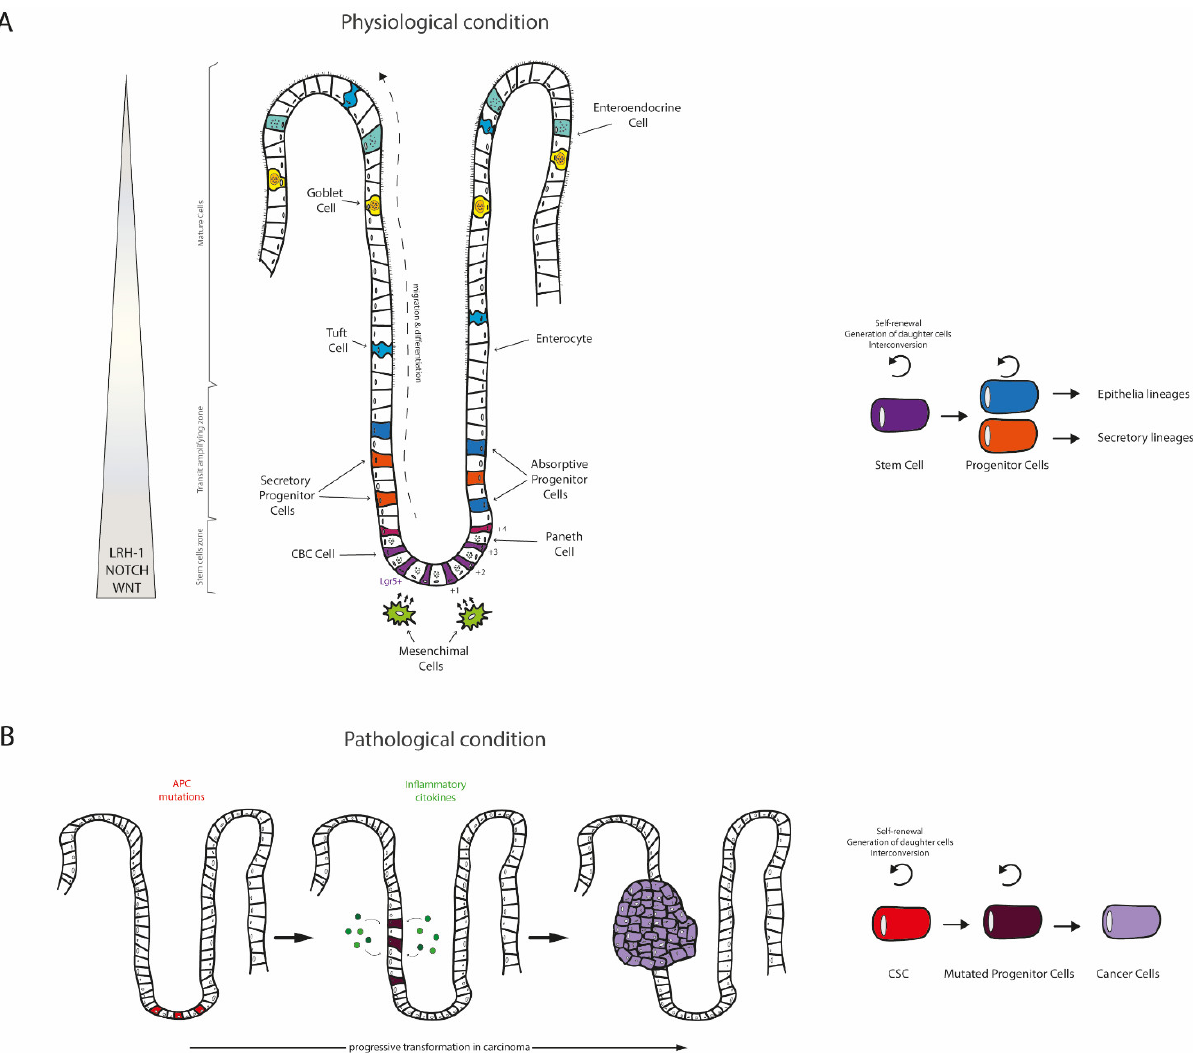
Figure 1. The intestine under physiological and pathological conditions. The small intestine presents a well-organized architecture, composed by villi surrounded by multiple crypts. The mucosa of large intestine lacks villi and shows only crypts. These structures are completely disrupted during cancer. ( A ) In physiological condition, the crypt based columnar (CBC) cells act as stem cells, expressing Lgr5 and generating a continuous flow of cells that move toward the tip. Notably, the main active pathways in the stem cell zone are those of WNT and NOTCH, which are strictly regulated by the expression of the Liver Receptor Homolog-1 (LRH-1). This scenario is present both in the small and in the large intestine. Paneth cells surround and metabolically sustain CBC cells located in position +1 to +3. In addition, mesenchymal cells can secrete factors that nurture the stem cells in the crypt. In the transit amplifying zone, progenitor cells divide quickly, in order to sustain the rapid cell renewal of the intestine, and differentiate in secretory (Tuft, Goblet, and enteroendocrine cells) or absorptive (enterocytes) lineages. ( B ) The colorectal cancer (CRC) can be caused by repetitive insults to the intestinal cells. The first event usually involves alterations to the WNT/ β -catenin pathway, followed by inflammatory cytokines exposition that drive cancer development. Notably, the cells responsible of tumor initiation and progression are the cancer stem cells (CSC) that retain characteristic of stem cells and allow an undefined and incessant cell growth together with the ability to invade distant tissues, promoting